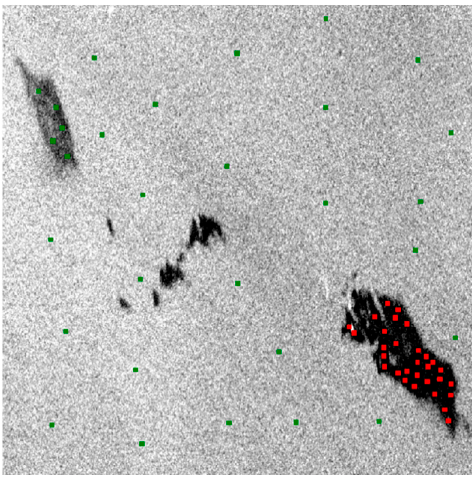
Figure 5. Demonstration of a selected area for analysis (taking VV 2 image as background); 24,000 pixels are picked as data samples.